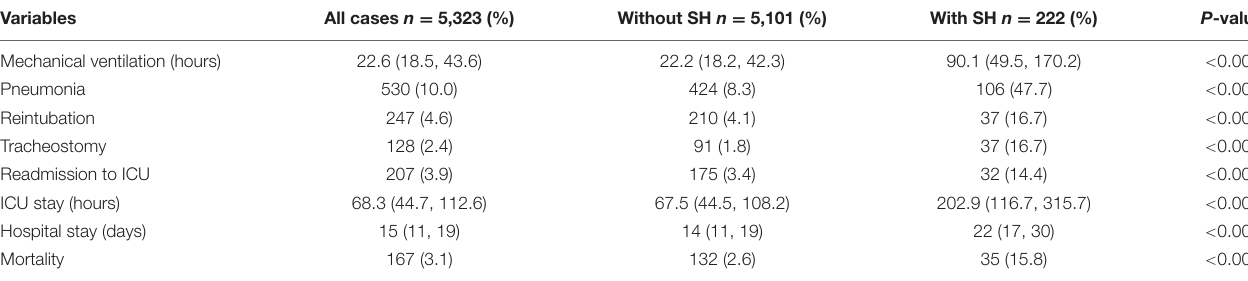
TABLE 4 | Postoperative variables in patients with and without SH after cardiac surgery. Variables All cases n = 5,323